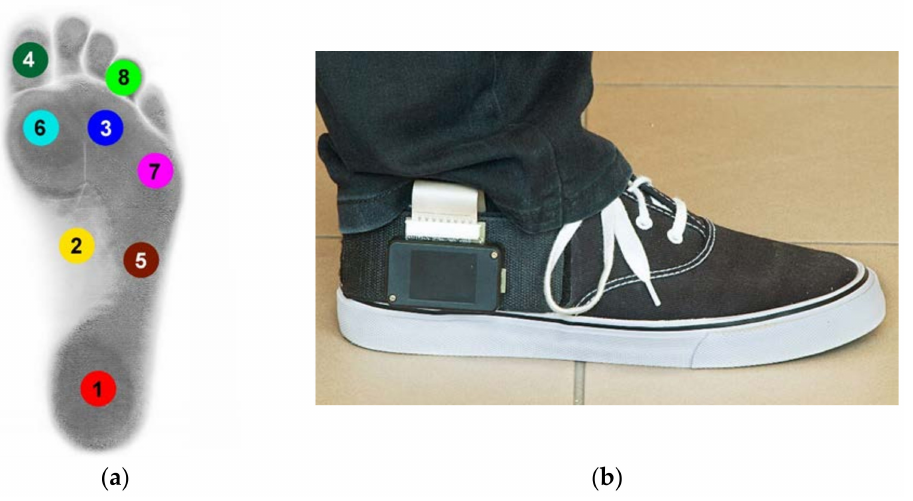
Figure 1. ( a ) Placement of 8 piezoelectric sensors in the shoe insole. ( b ) Ortopiezometr—transducer attached to the